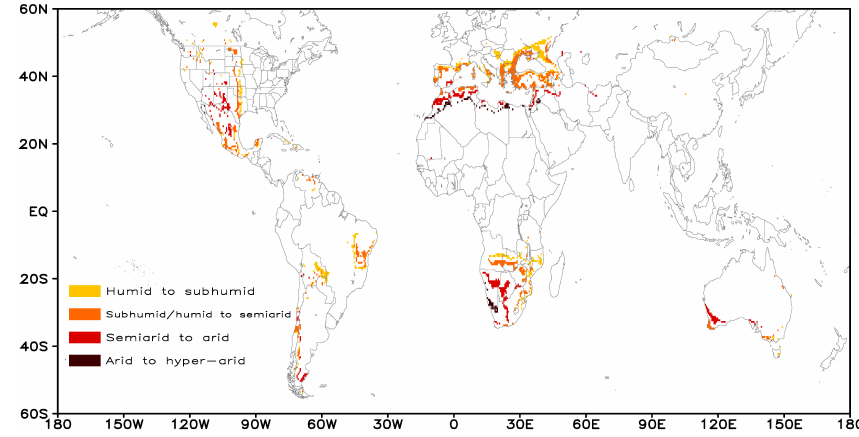
Fig. 6. Same as Fig. 5a but for projected area changes to drier types where more than 80% of the 27 models agree on the sign.